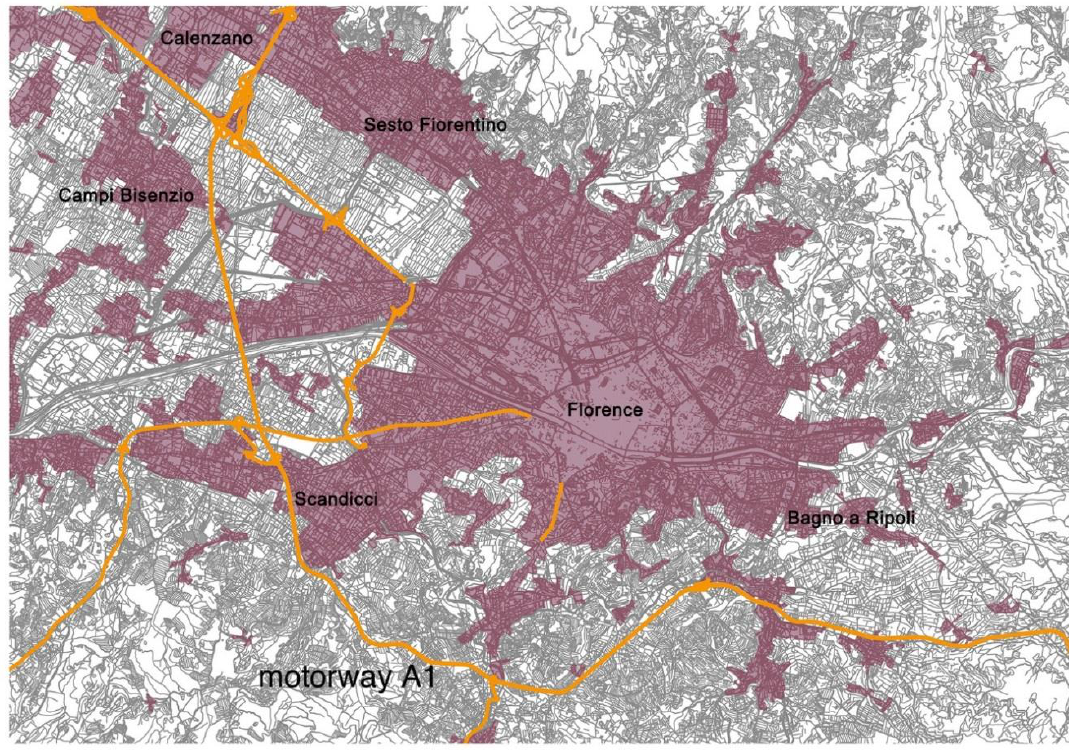
Figure 1. The area of Florence: site plan.